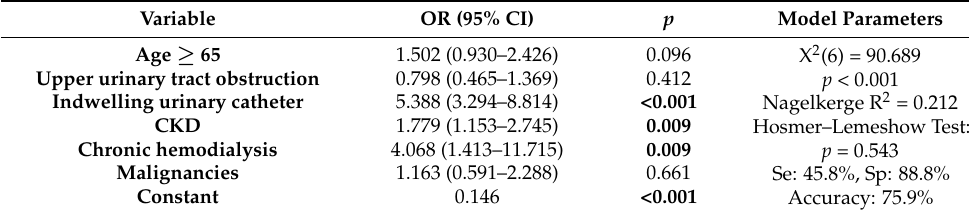
Table 6. Multivariate logistic regression for prediction of MDR.